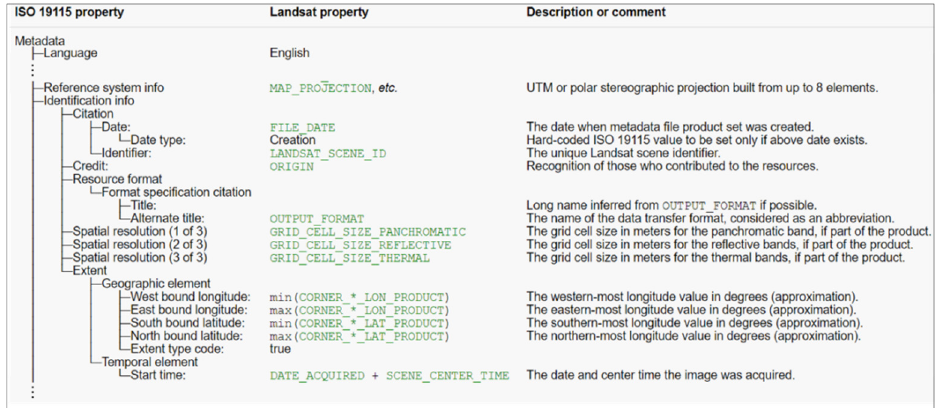
Figure 15. Mapping from Landsat property to ISO 19115 property.